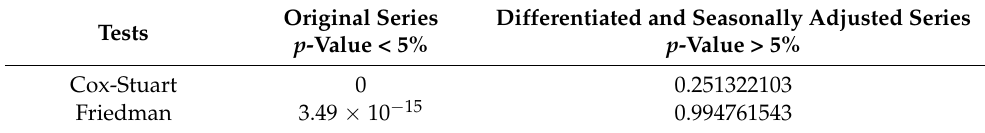
Table 4. Non-parametric tests for trend and seasonality analysis.